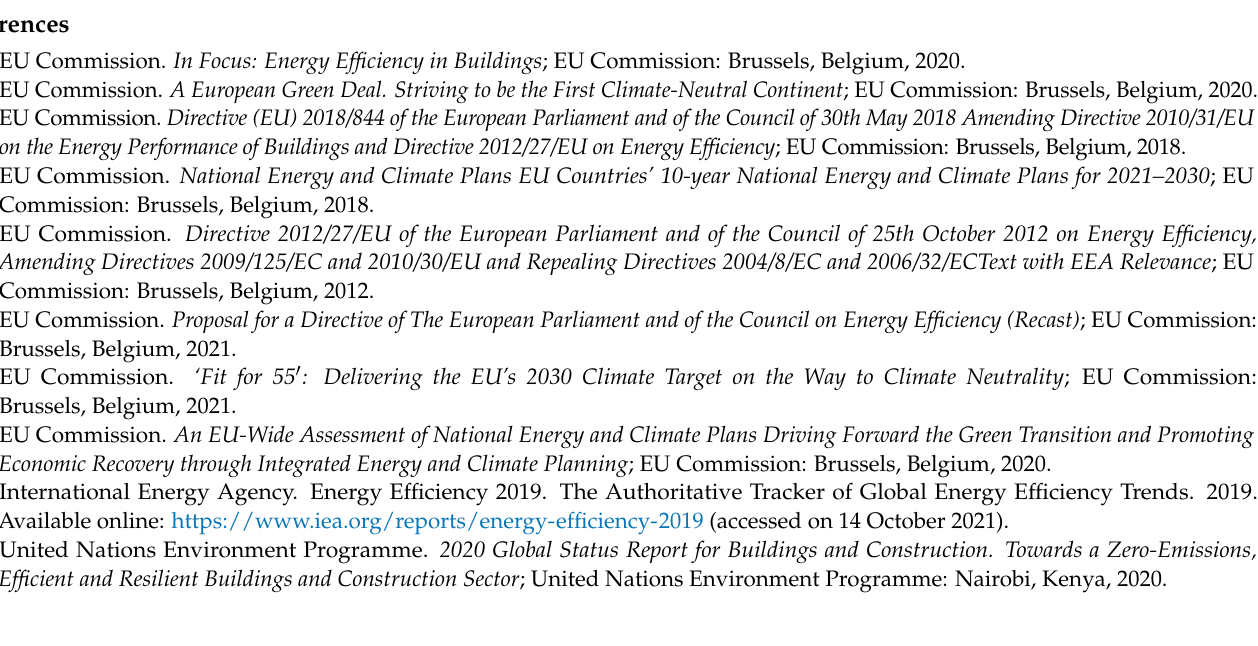
Figure A8. Roof-Geometrical models ( a ) current field, ( c ) ridge, ( e ) eaves; Isothermal ( b ) current field, ( d ) ridge, ( f ) eaves.